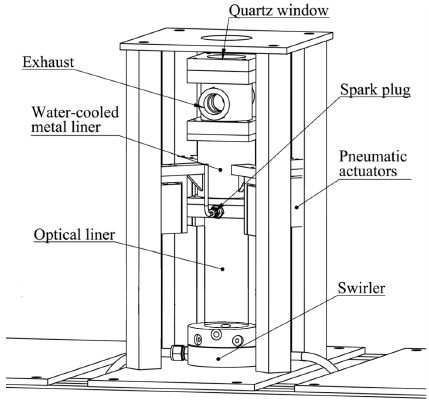
Figure 2. Swirl-stabilised combustor.